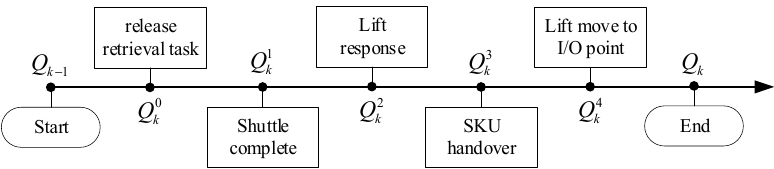
Figure 4. Cycle time analysis for the retrieval task k .